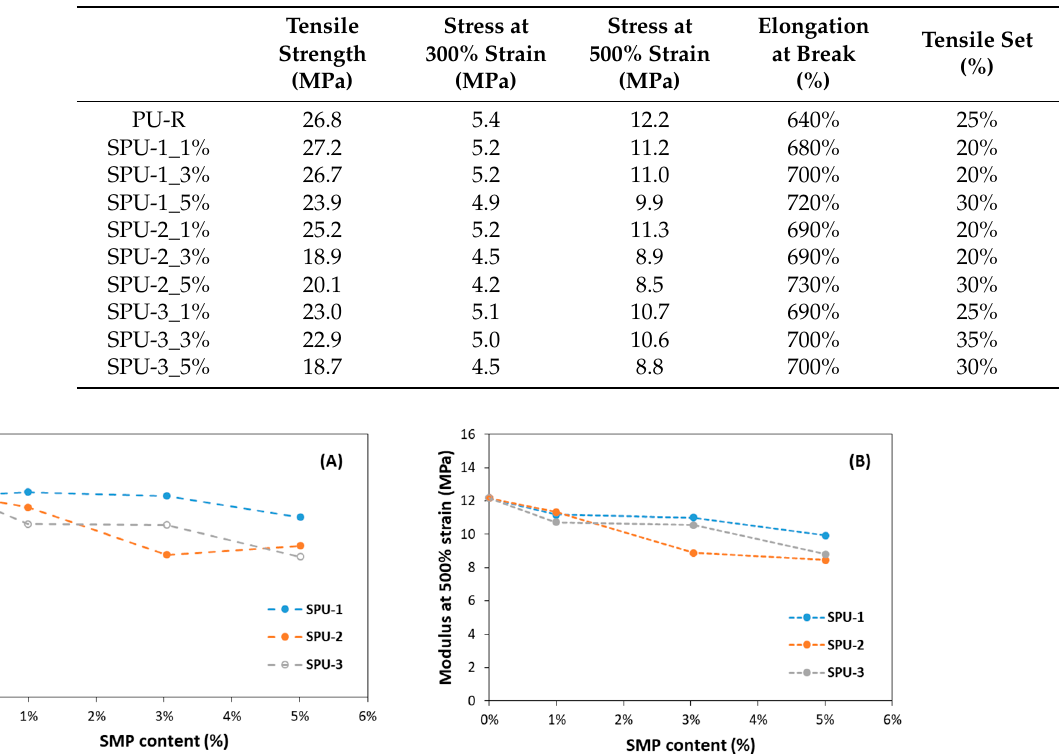
Figure 3. Representative second DSC heating scans of PU − R and SPU coatings in nitrogen at a heat- ing rate of 20 °C/min. Table 4. Tensile properties of PU − R and SPU coating films.